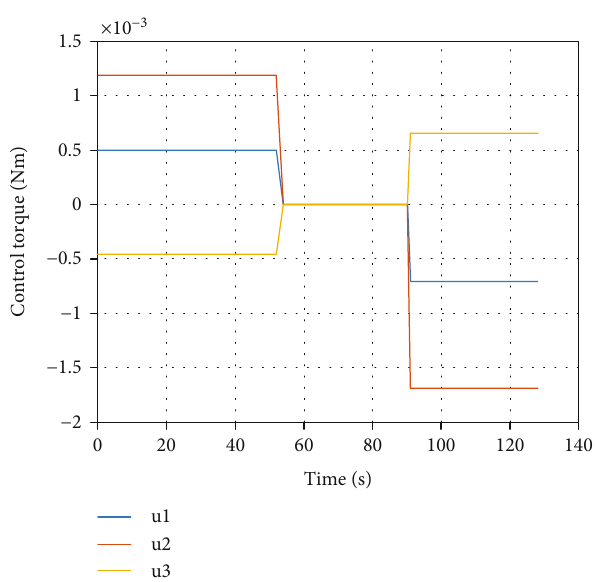
Figure 6: Control torque time history based on the cross-mutation grey wolf optimizer.